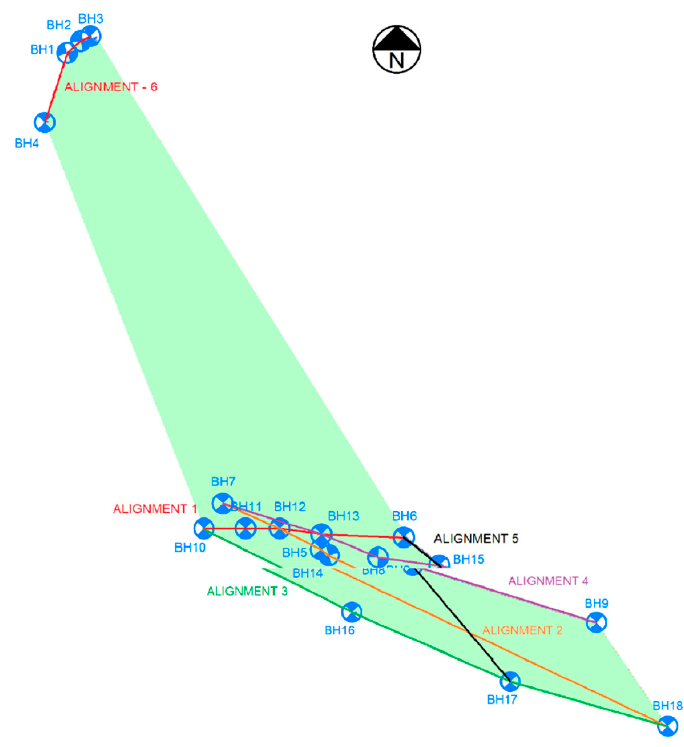
Figure 3. Layout plan of Case Study 2.